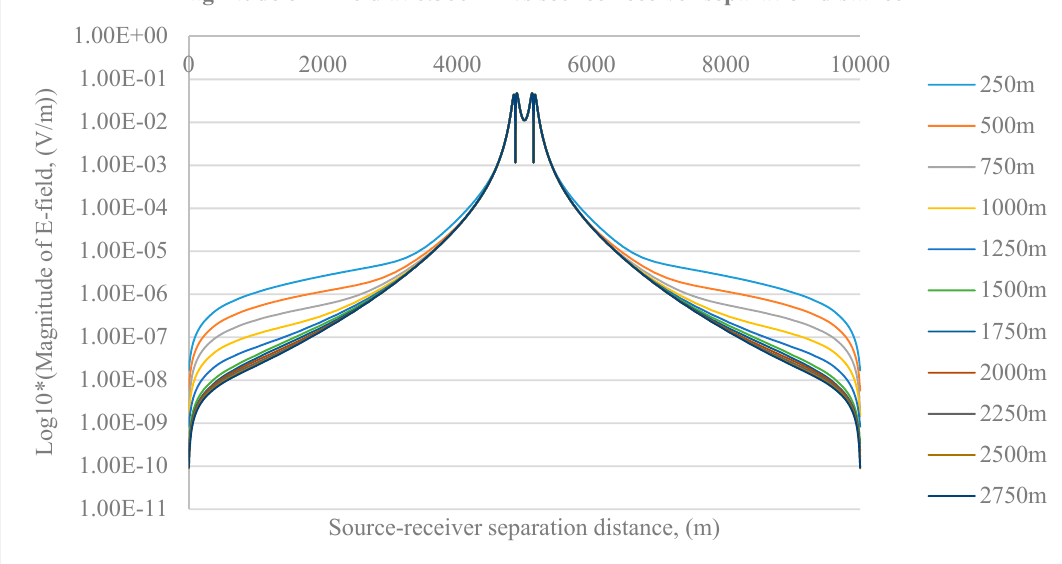
Figure 6. Log10 of magnitude of electric field at 0.5 Hz versus source–receiver separation distance (offset). Different hydrocarbon depths yield different EM responses. The offset is from 0 m (left of the SBL model) to 10,000 m (right of the SBL model).